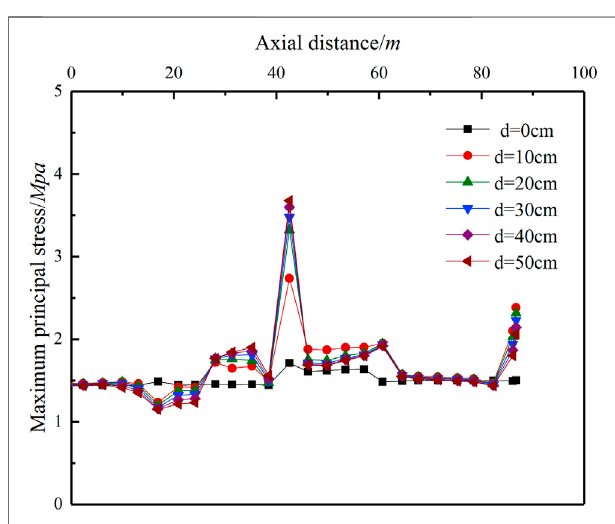
FIGURE 10 | Maximum principal stress curve of underground utility tunnel obliquely crossing the ground fi ssure (inclination 64 ° ).